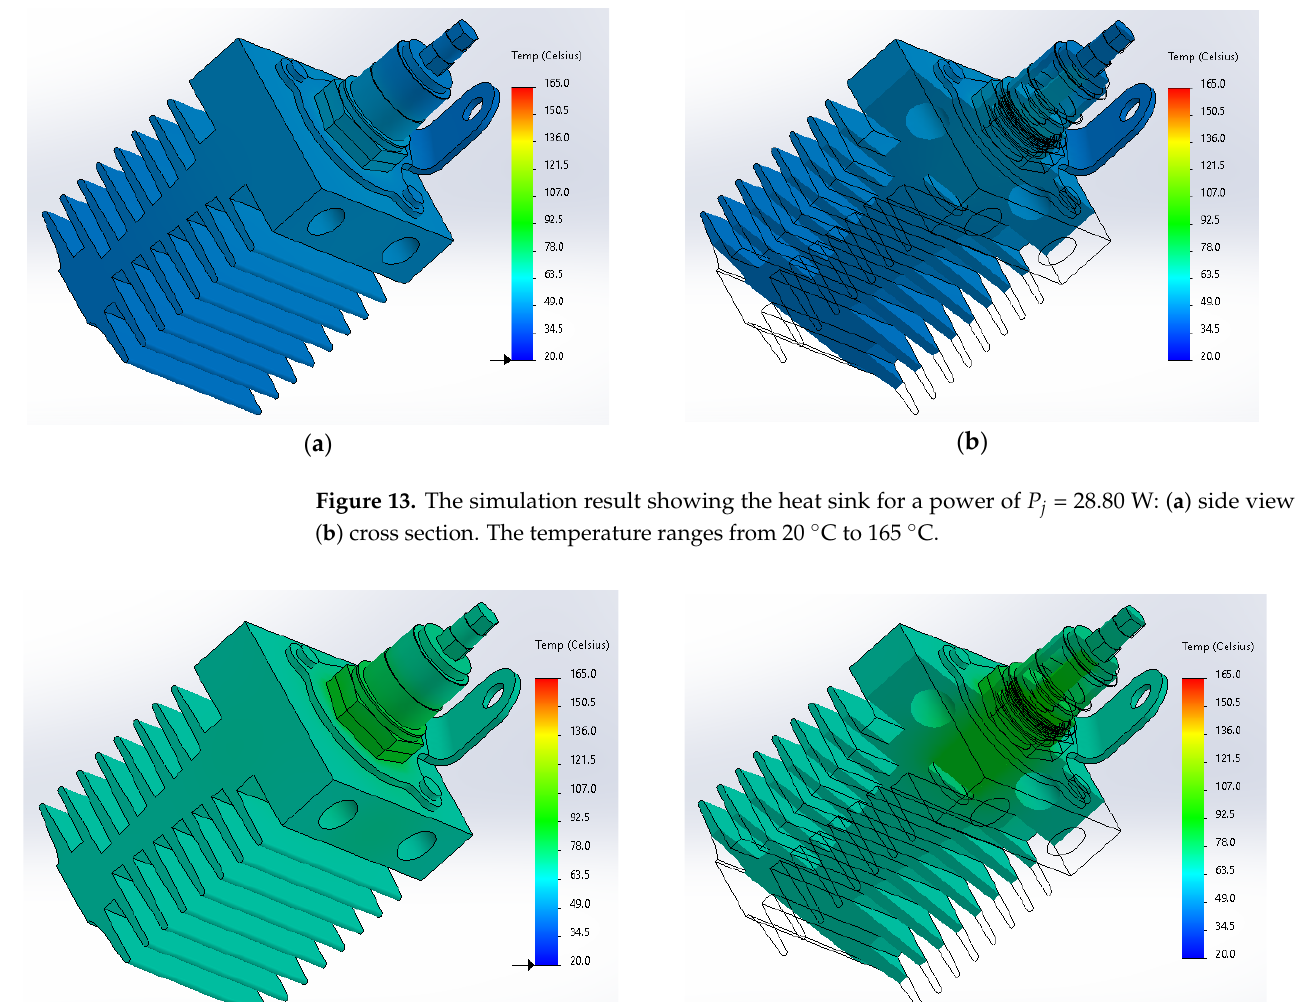
( b ) Figure 15. The simulation result showing the heat sink for a power of Pj = 74.36 W: ( a ) side view; ( b ) cross section. The temperature ranges from 20 °C to 165 °C. ( a ) ( b ) Figure 16. The simulation result showing the heat sink for a power of Pj = 117.99 W: ( a ) side view; ( b ) cross section. The temperature ranges from 20 °C to 165 °C.